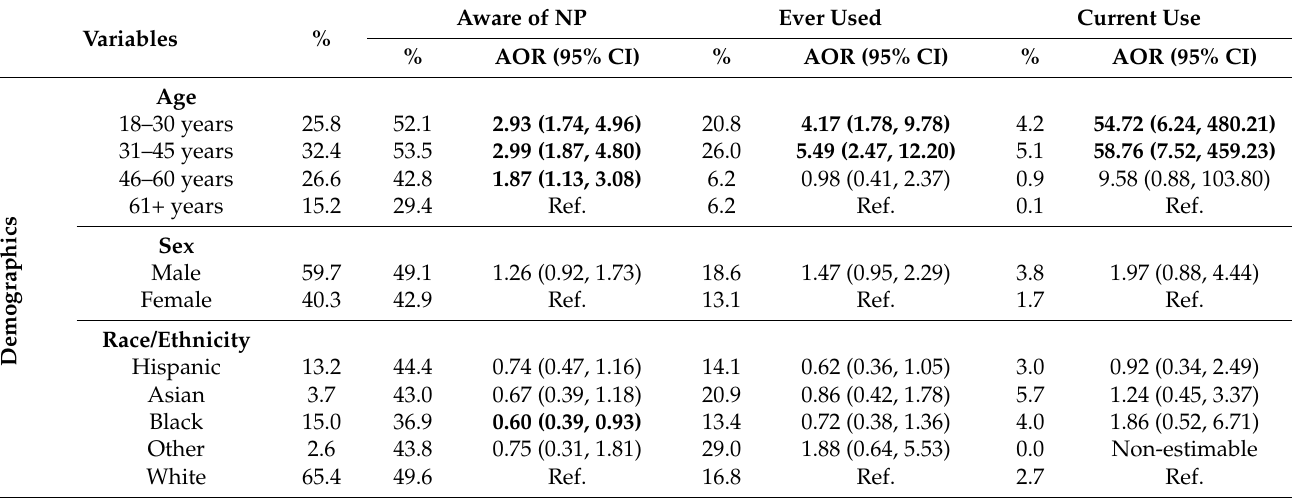
Table 1. Weighted prevalence of nicotine pouches awareness, ever use, and current use and their associations with demographics and tobacco product use statuses, 2021 (N =